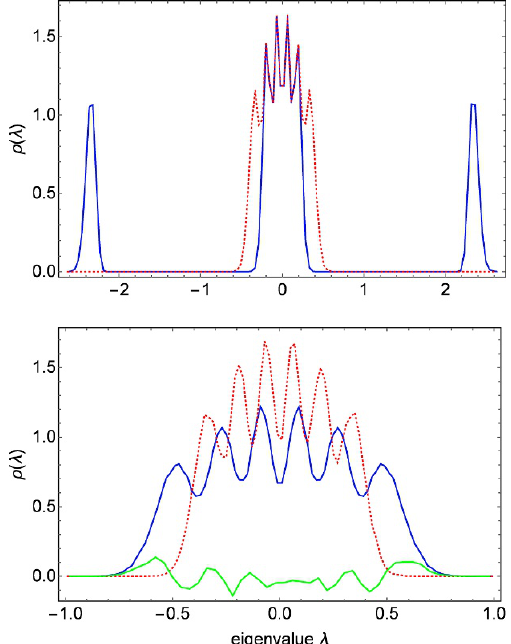
Figure 8 . The distributions (cid:26) eig dotted red curve corresponds to t (cid:0) panel: the solid curves correspond to the (cid:26) eig in E 0 , the dotted red curve is taken from the top